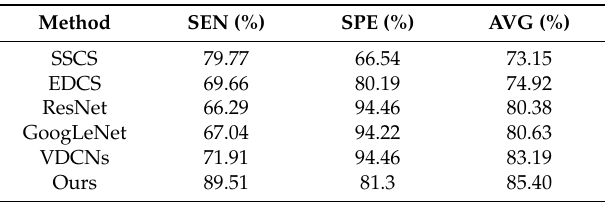
Table 3. Comparison of classification rates on Dataset 1.